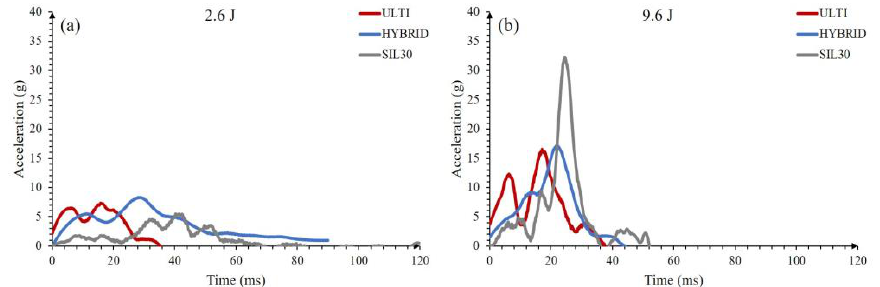
Figure 11. Acceleration response of all three double-stacked vertically-graded configurations; ( a ) 2.6 J, ( b ) 9.6 J. ( a ) 2.6 J, ( b ) 9.6 J.